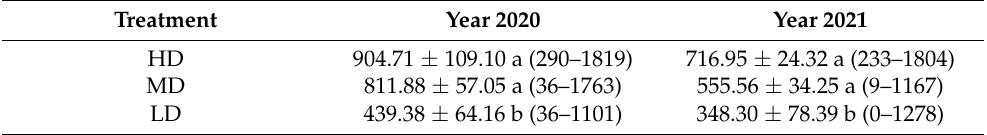
Table 3. Number of pollen grains adhered (mean ± SE), minimum and maximum values between parentheses, on the stigma of triploid watermelon flowers for each treatment (release density: HD, MD and LD), in both years of the